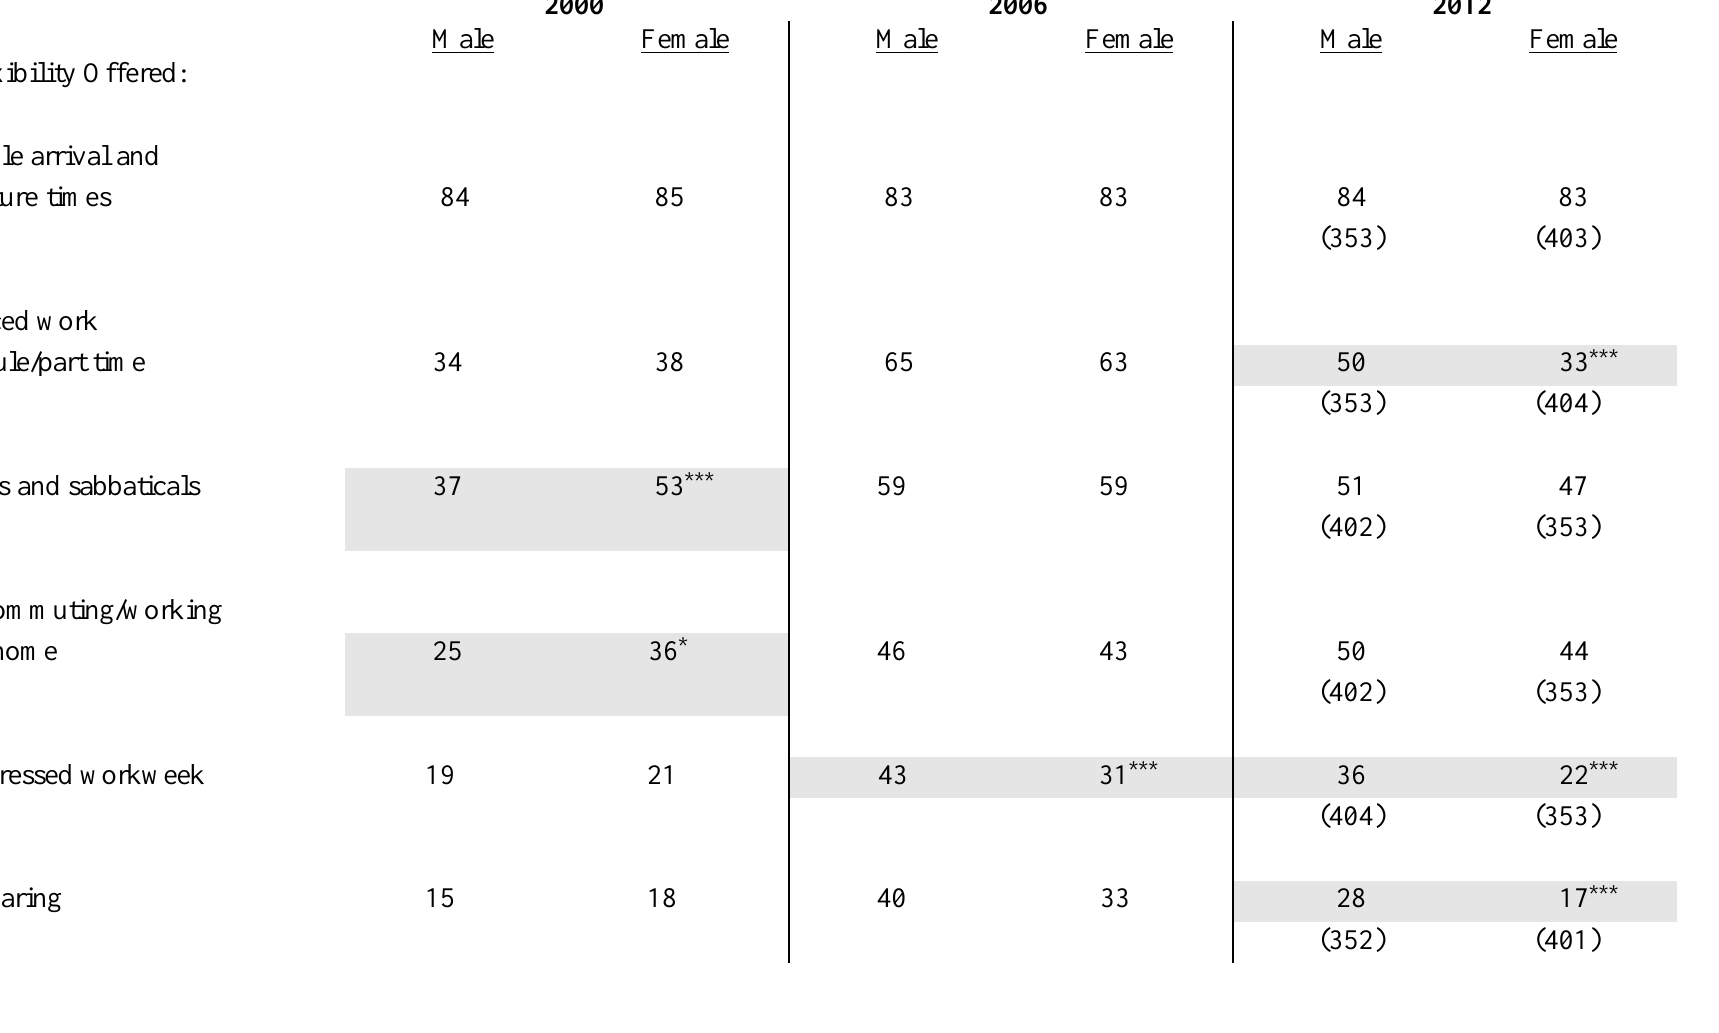
Table 23. Organization’s Policies (percent reporting existence of